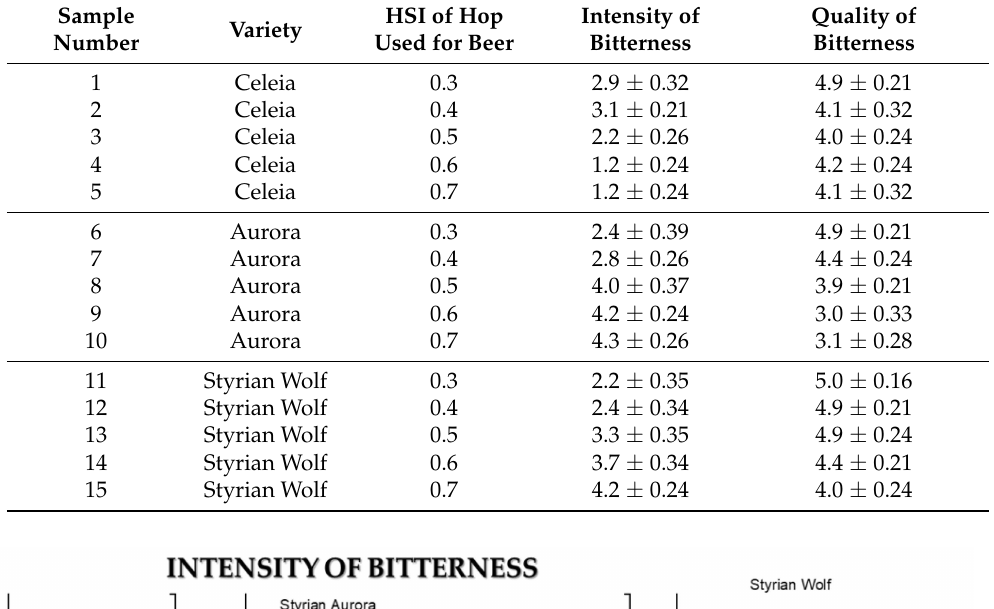
Table 6. Results of sensorial analysis for intensity and quality of bitterness, presented as mean value ± standard deviation.